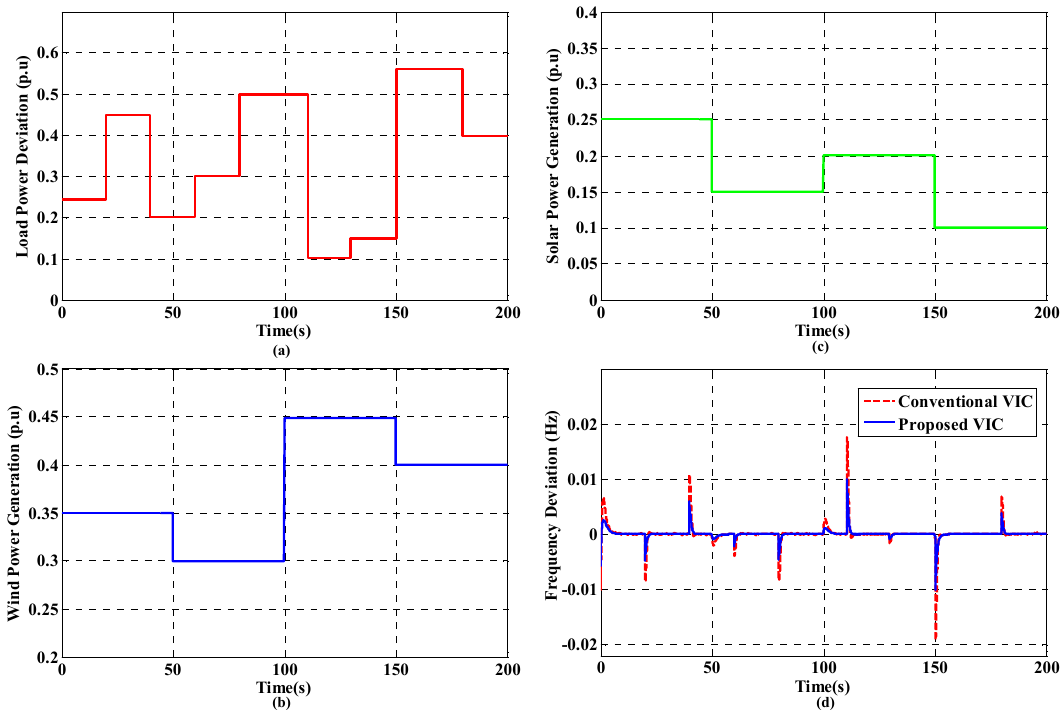
Figure 12. MG disturbances and frequency response for scenario 5.2.1. ( a ) Considered load disturbance pattern. ( b ) WTG output power. ( c ) PV output power. ( d ) Resulted frequency responses.